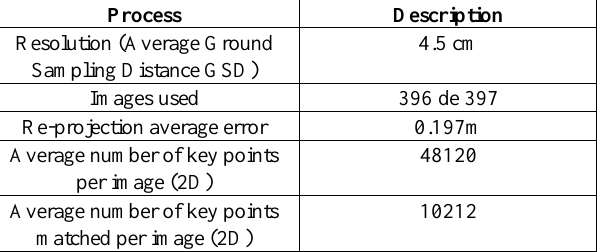
2.2.1 Table 2. Processing of UAV images, from February 2, 2018.